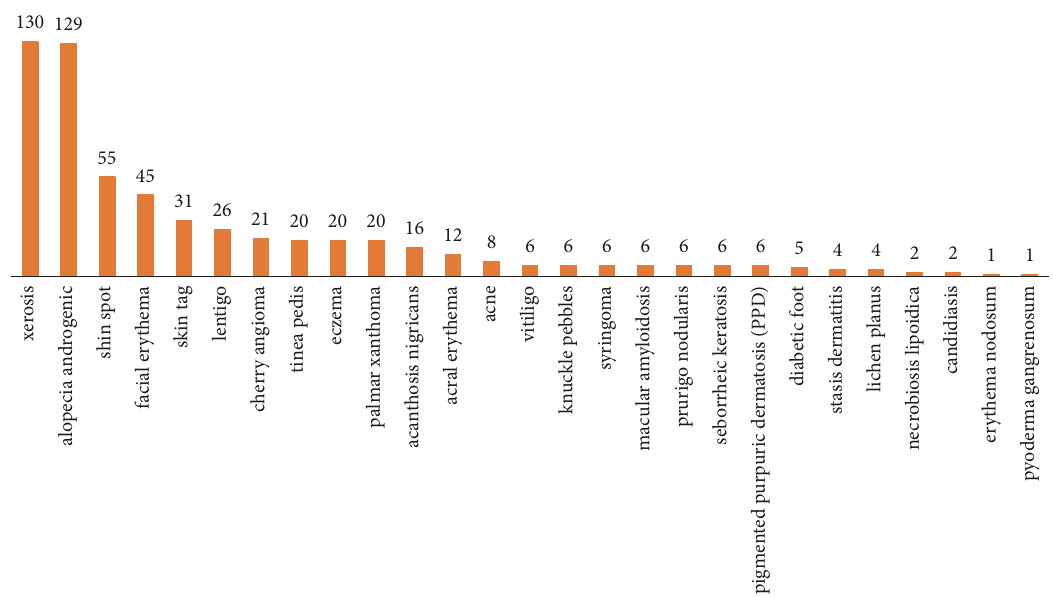
afterwards. Ridging nail (7.6%) was the most common nail manifestation detected. In a research conducted by Goyal et al. on 100 diabetic patients, Xerosis was reported as the most common cutaneous manifestation with a prevalence of 44% and was followed by skin dermopathy and diabetic tags